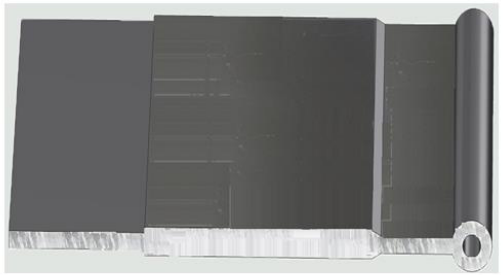
Figure 20. Qualified extrudate with electrophoretic coating through the optimal die.